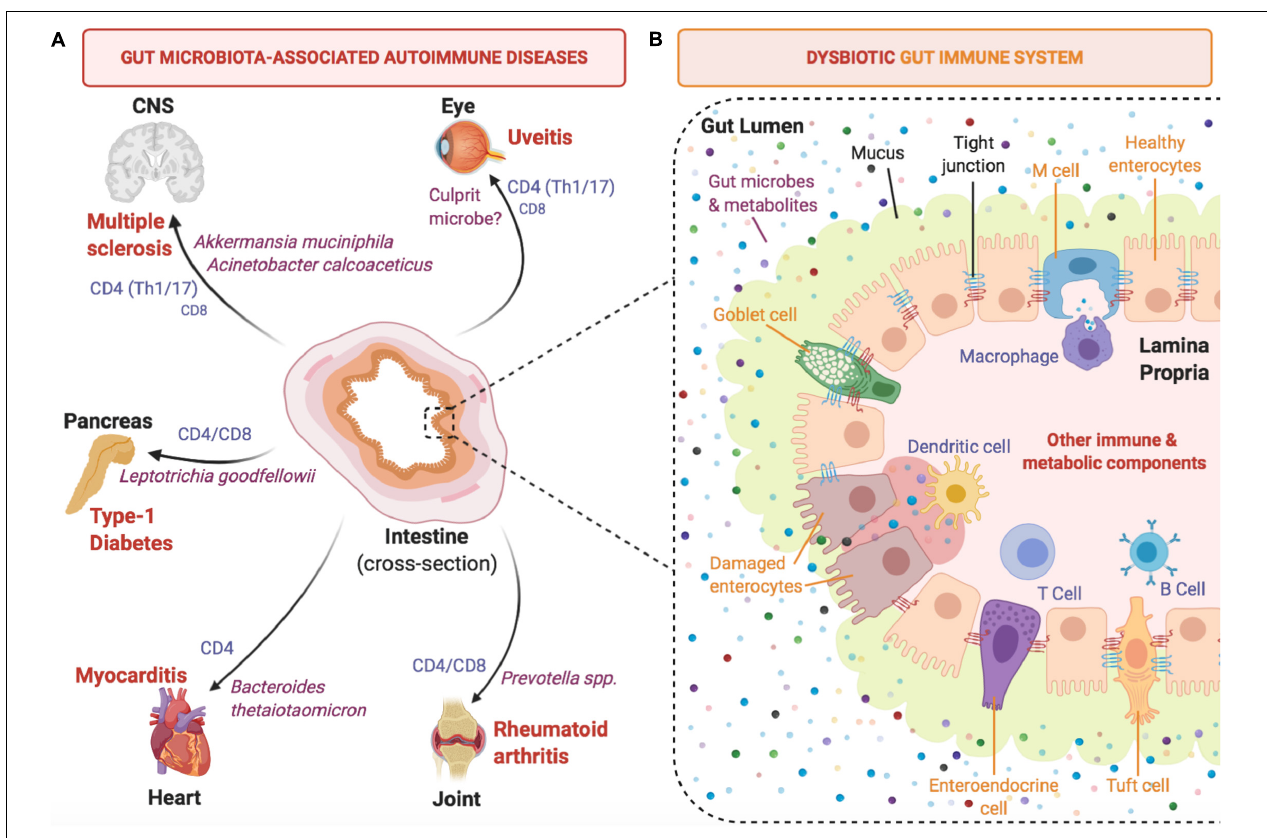
FIGURE 1 | Development of autoimmune diseases is linked to gut microbiota and intestinal immunity. (A) Selected tissue-specific autoimmune diseases (extra-intestinal) are depicted with reported culprit microbes and effector T cell types involved in pathogenesis. (B) A close-up intestinal cross-section of a segment of the mammalian colon that focuses on the host-microbiota interface and highlights key immune cell mediators that contribute to the induction of pro-inflammatory cytokines under dysbiotic